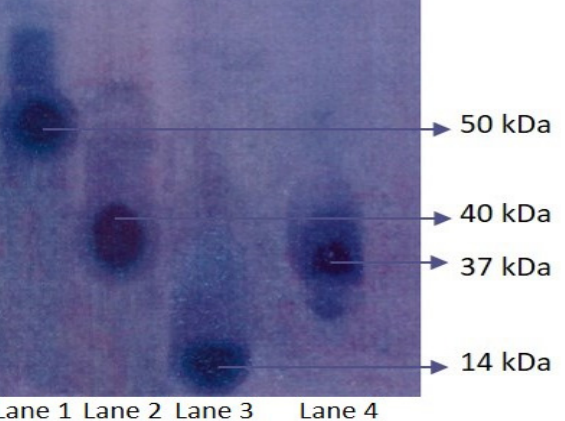
Figure 3. Thernogravimetric and different thermogravimetric analysis of fucoidan from the brown seaweed Sargassum ilicifollium . 3.2. Characterization of Fucoidan from S. ilicifolium The FT-IR analysis of fucoidan extracted from S. ilicifolium was shown in Figure 4. The carbohydrate O–H stretching tremor was assigned to the bands at 3292.42 and 3258.45 cm − 1 (Table 3, Figure 4). The stretching and bending vibrations of the alkyl groups (–CH 2 − , CH 3 ) were assigned to the absorption band at 2930.59 cm − 1 , indicating the existence of C=O stretching vibrations of O-acetyl groups. CH 2 was assigned to the band at 1412.35 cm − 1 (galactose, xylose). The presence of sulphate groups is indicated by the fucoidan charac- teristic absorption band at 1246.34 cm − 1 (S=O Stretching, Fucose, O-acetyl group). The ab- sorbance at the wavelength of 1029.0 cm − 1 indicates C-O-SO3 vibration. The C-O-S bend- ing vibration of the sulphate substitute at the axial C 2 and C4 positions were assigned to the bands at 882.96 and 816.06 cm − 1 , respectively. Figure 5 depicts that the 1 H NMR range